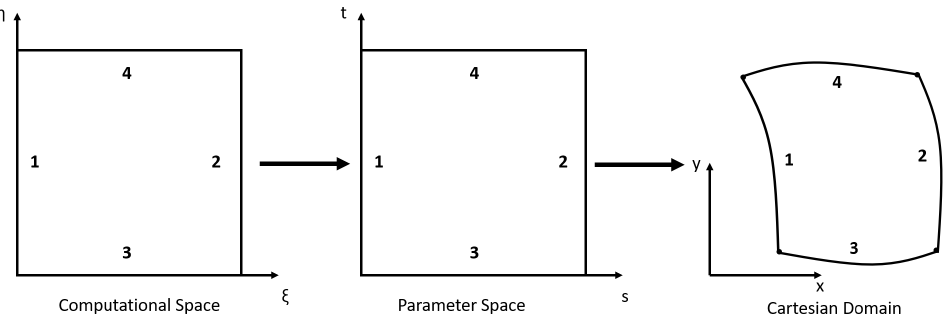
Figure 2. Transformation from computational space to cartesian domain. Adapted from Reference